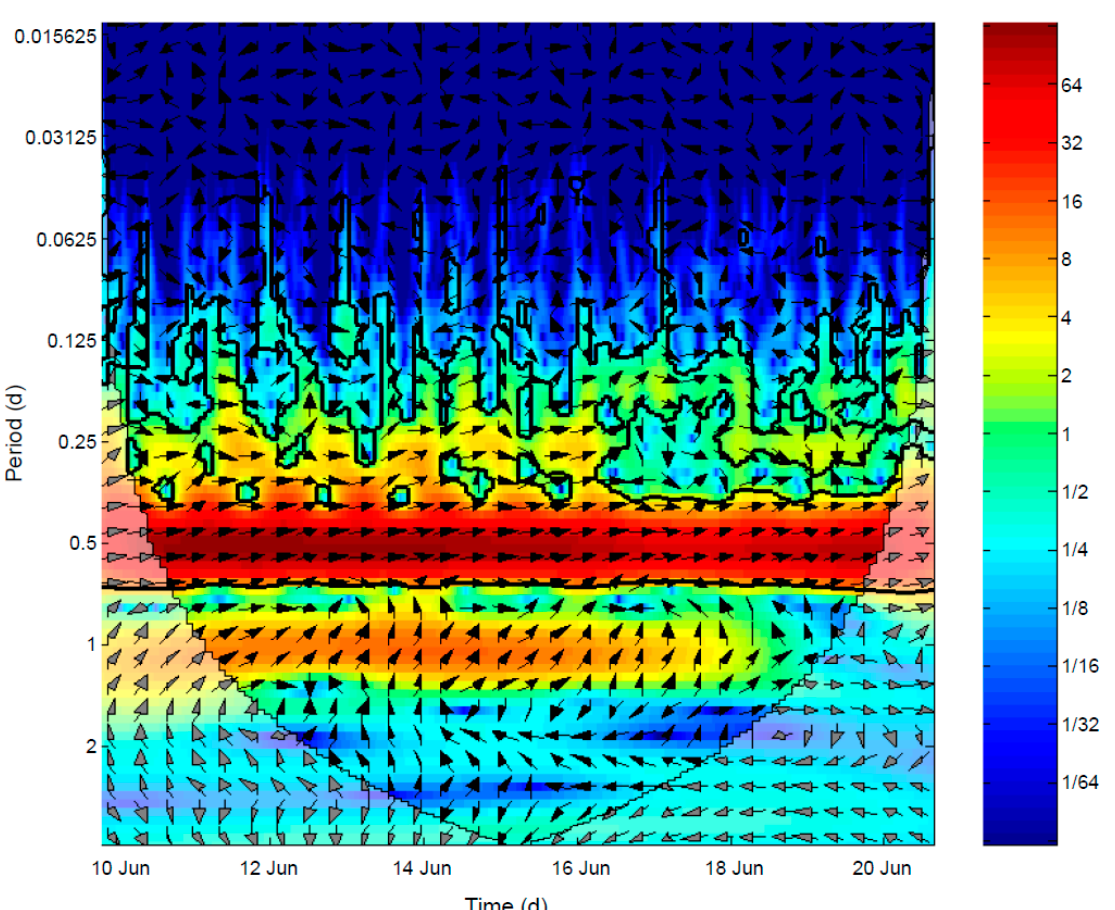
Figure 9. The phase di ff erence in the tidal discharge phase between the eastern and western branches. The black contours represent the 95% confidence level for red noise, and the cone of influence (COI) where edge e ff ects might distort the picture is shown as a lighter shade. The relative phase relationship is shown as arrows (with in-phase pointing right, anti-phase pointing left, and the first time series leading the second one by 90 ◦ pointing down). The wavelet power is log ( A 2 / v ), where A is the wavelet amplitude and v is the variance of the original tidal signals. The y -axis is on a log 2 scale.